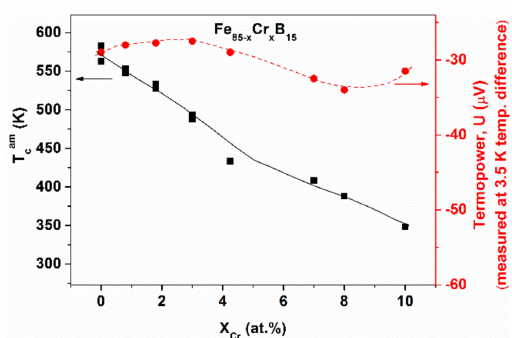
Figure 8. Change of Curie temperature ( T Cam ) and thermopower ( U ) versus Cr content in (Fe 85- x Cr x )B 15 glasses (adopted from [65], with permission from the Institute of Physics of the Polish Academy of Sciences, 2010).